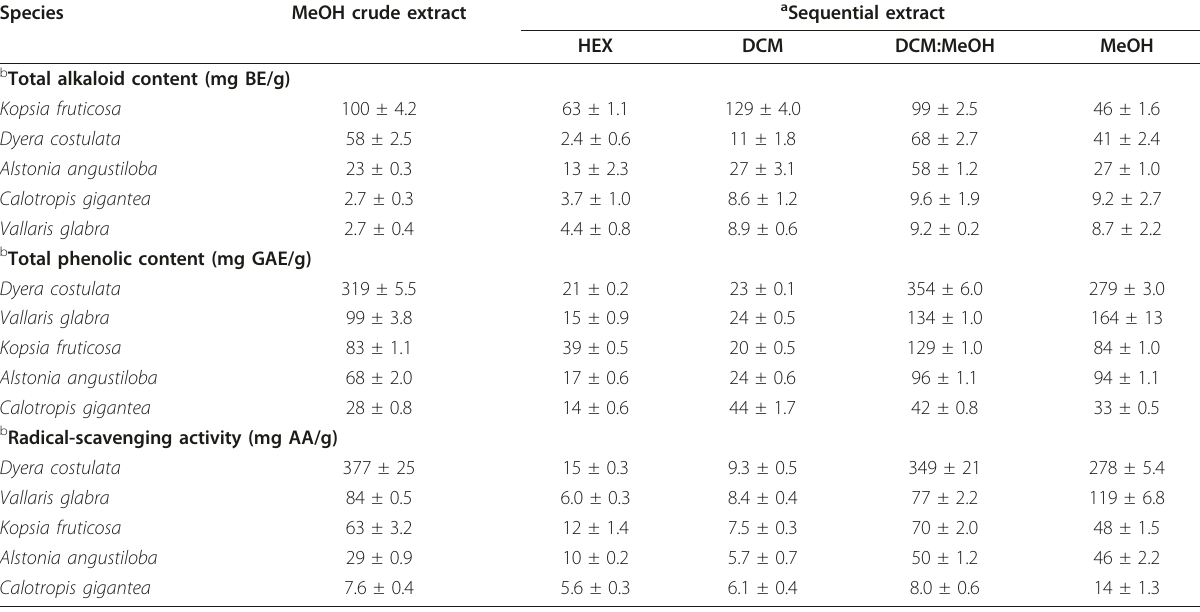
Table 3 Phytochemical analysis of total alkaloid content, total phenolic content and radical-scavenging activity of leaf extracts of Apocynaceae species Species MeOH crude